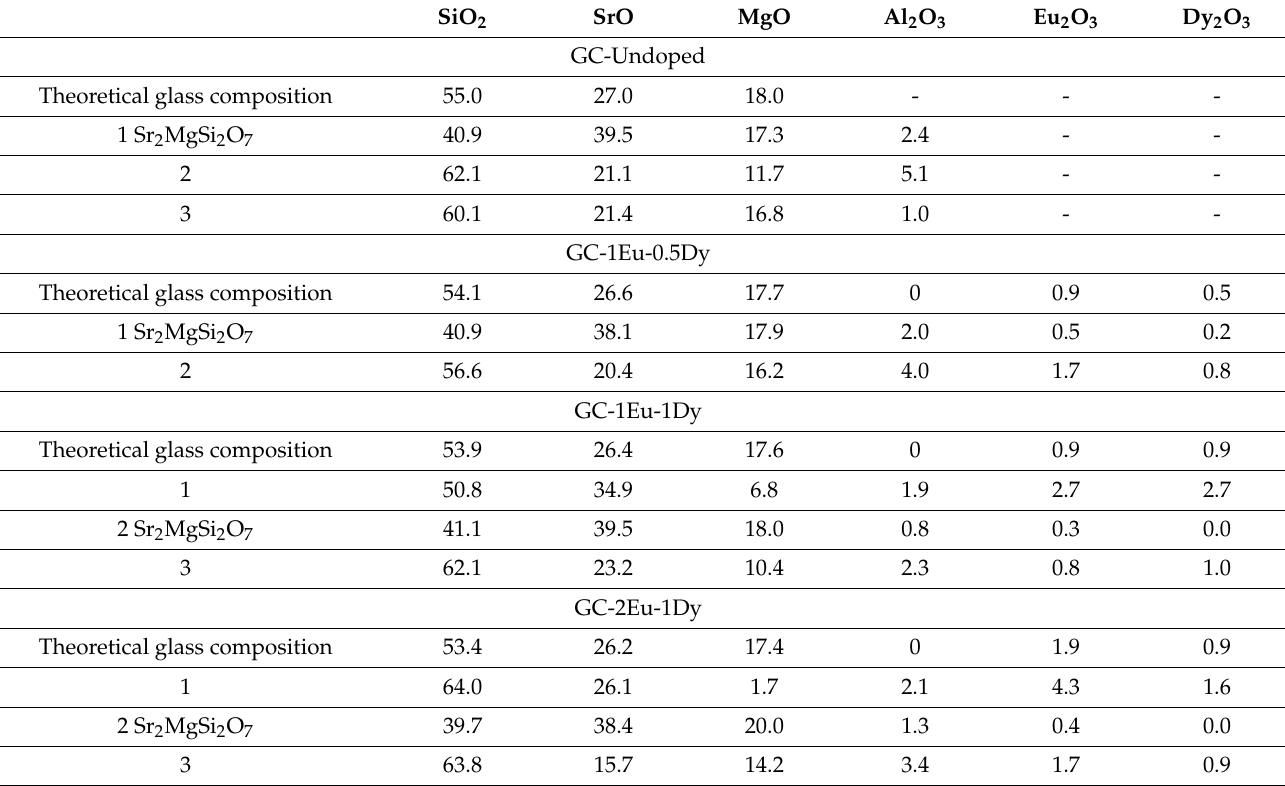
Figure 4. SEM images of ( a ) GC-undoped, ( b ) GC-1Eu-0.5Dy, ( c ) GC-1Eu-1Dy, and ( d ) GC-2Eu-1Dy glass-ceramics. Table 6. Compositional analysis (mol%.) of GC-Undoped, GC-1Eu-0.5Dy, GC-1Eu-1Dy, and GC-2Eu-1Dy glass-ceramics as determined by EDX corresponding to the points shown in Figure 4.